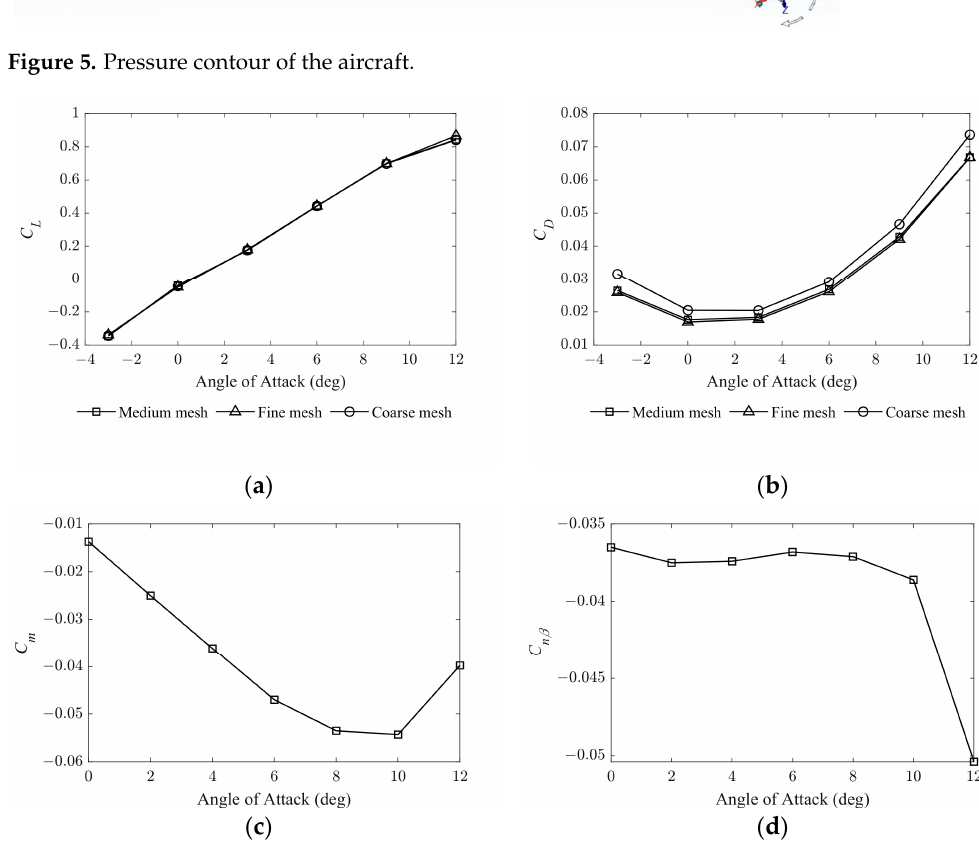
Figure 6. Longitudinal aerodynamic coefficients: ( a ) lift coefficient (sideslip angle β = 0), ( b ) drag coefficient (sideslip angle β = 0), ( c ) pitch-moment coefficient, and ( d ) directional static stability derivative (per radian).